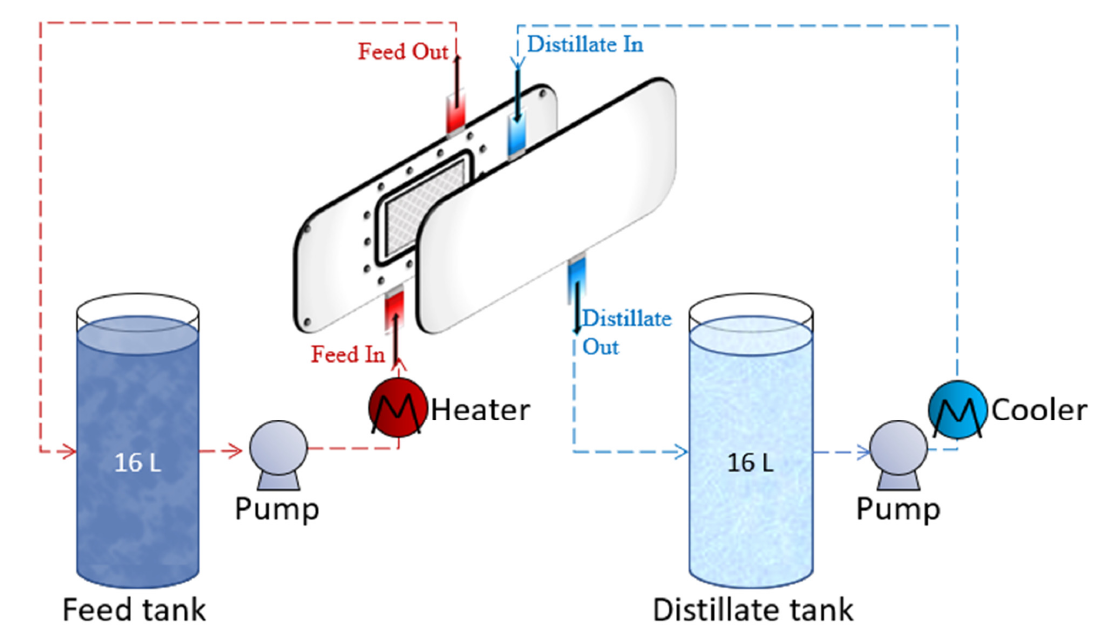
Figure 2. Schematic diagram for DCMD pilot unit.